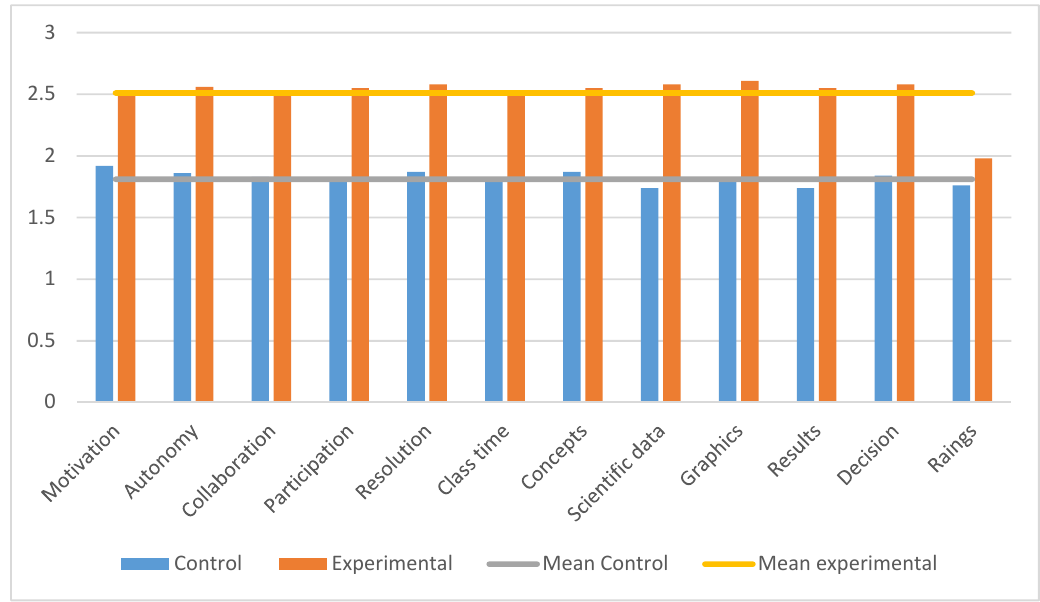
Figure 5. Comparison between control groups and experimental groups. Table 5. Study of the value of independence between the control groups and the experimental groups.